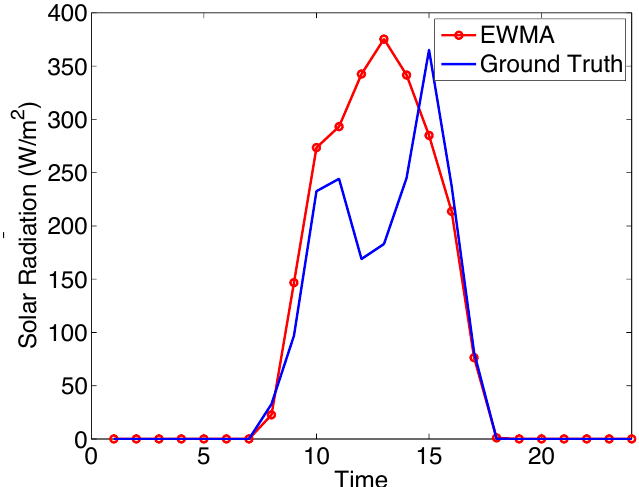
Figure 1. The energy model deviates from the ground truth. EWMA, Exponentially-Weighted